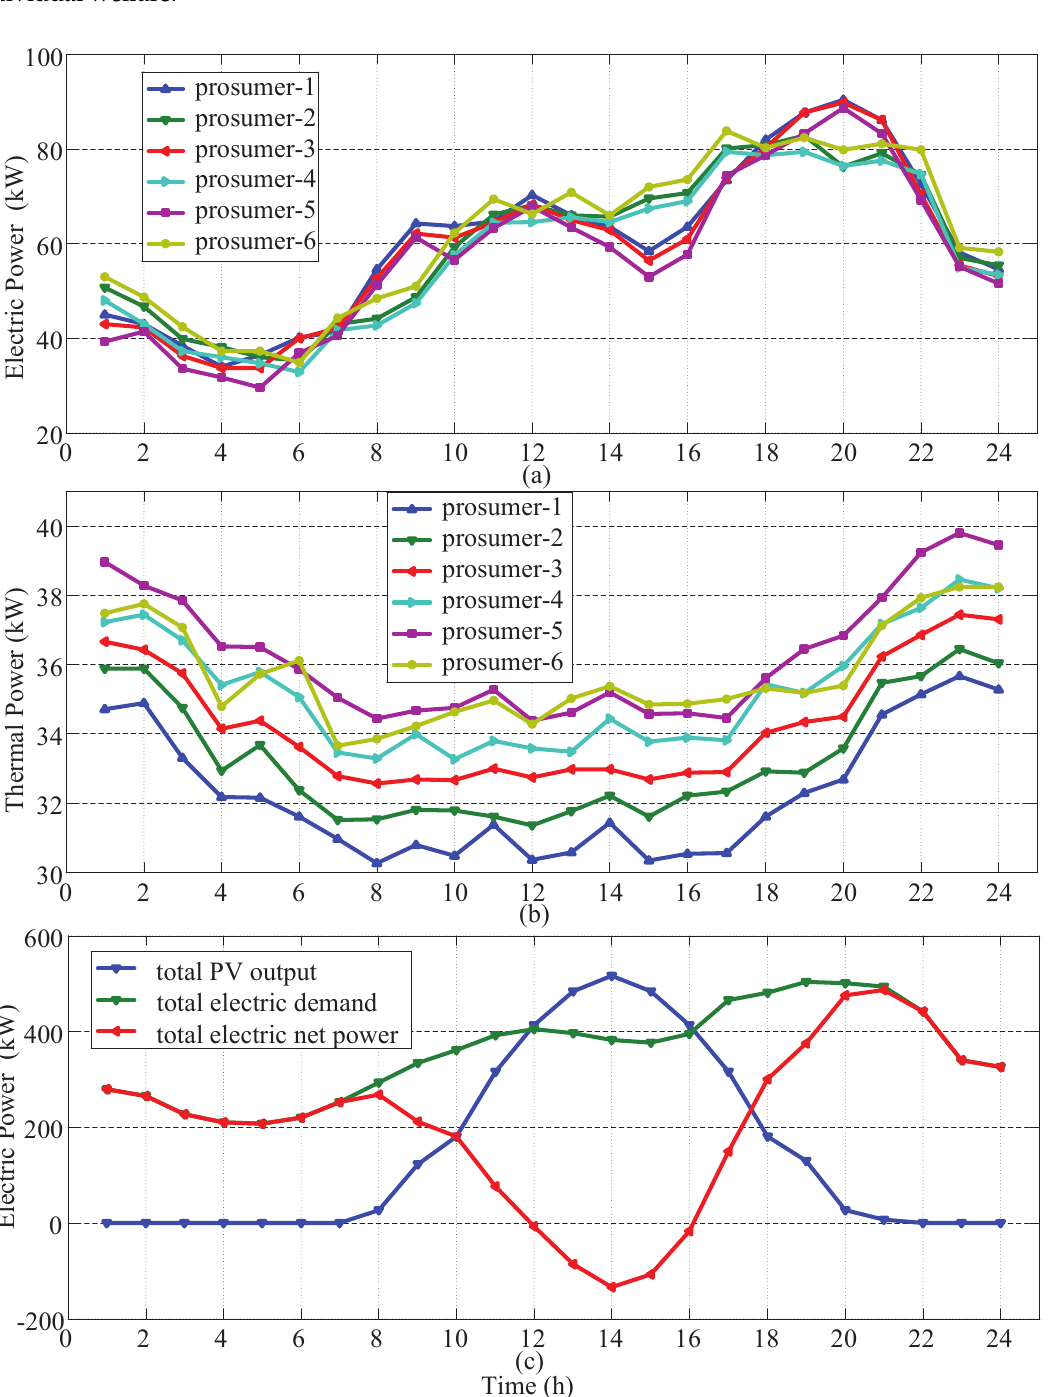
Figure 2. Daily load curves of prosumers: ( a ) daily electric load curves; ( b ) daily thermal load curves; ( c ) daily electric net power